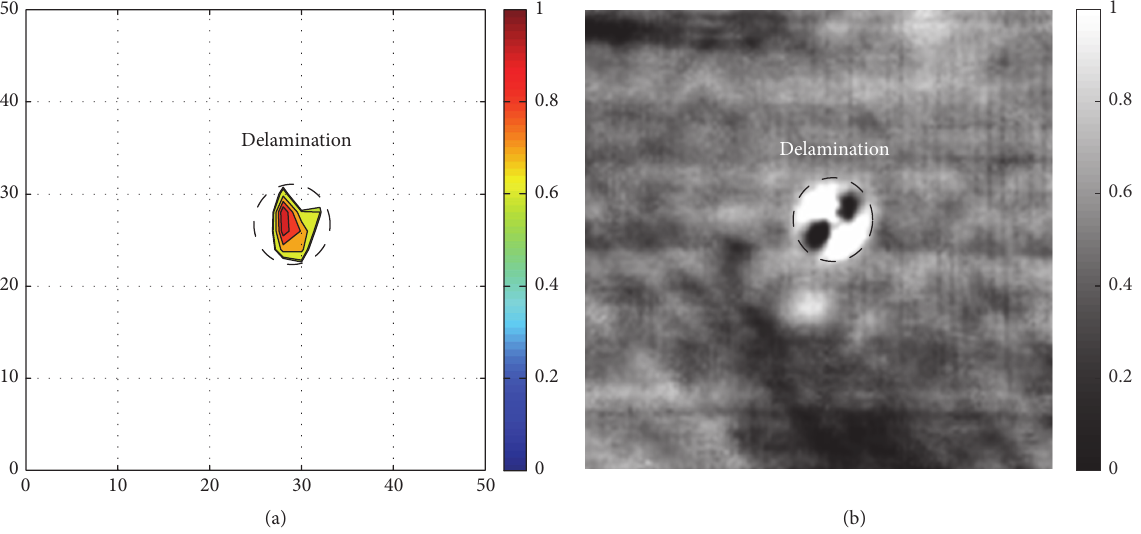
Figure 8: Automated delamination visualization results: (a) ZLCC image and (b) thermographic image.